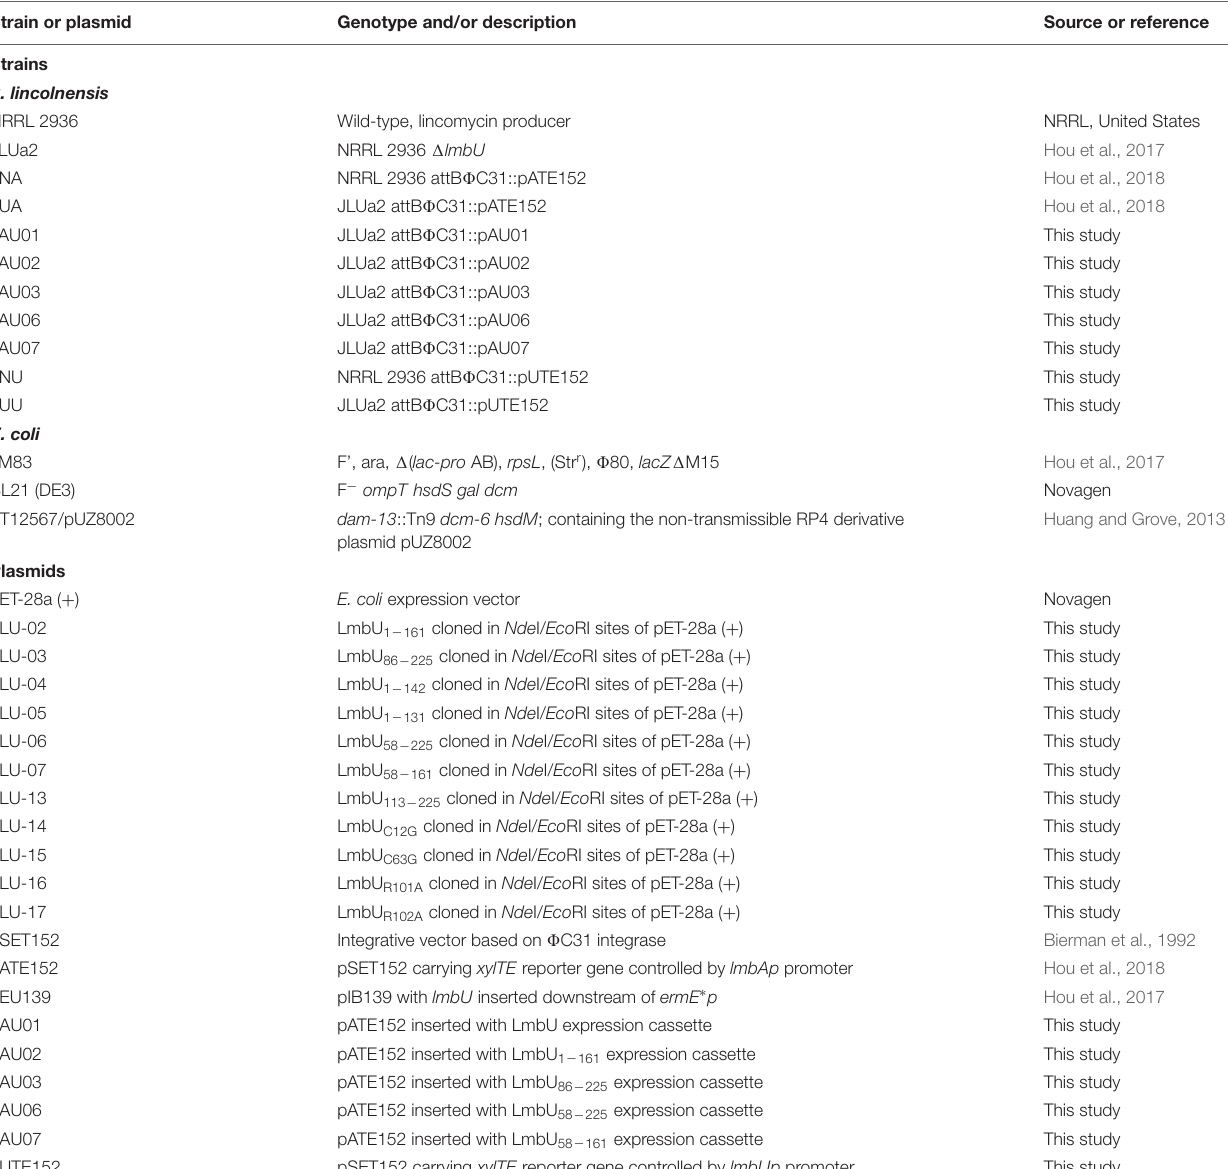
TABLE 1 | Strains and plasmids used in this